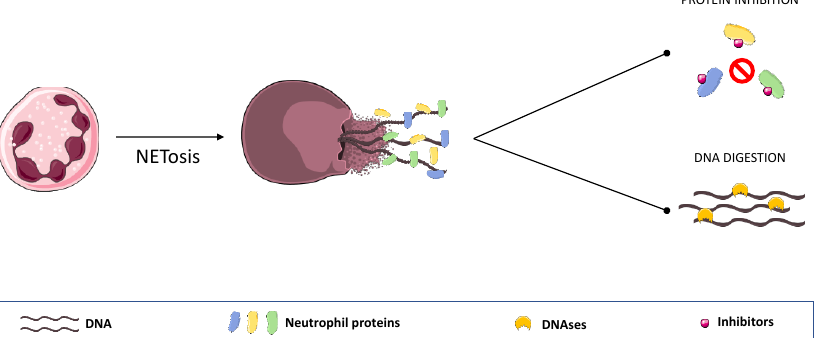
Figure 2. A summary of the different approaches used to block neutrophil extracellular traps for- mation.